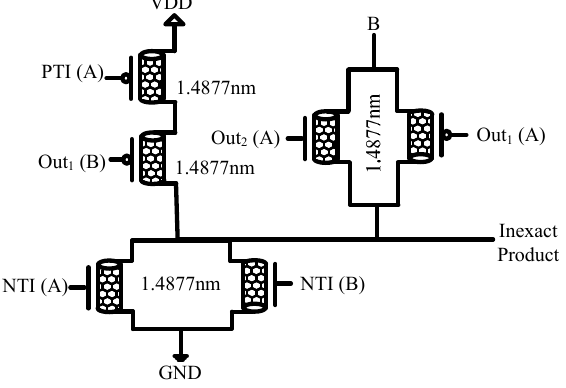
Figure 7. Design of the fifth proposed inexact design.